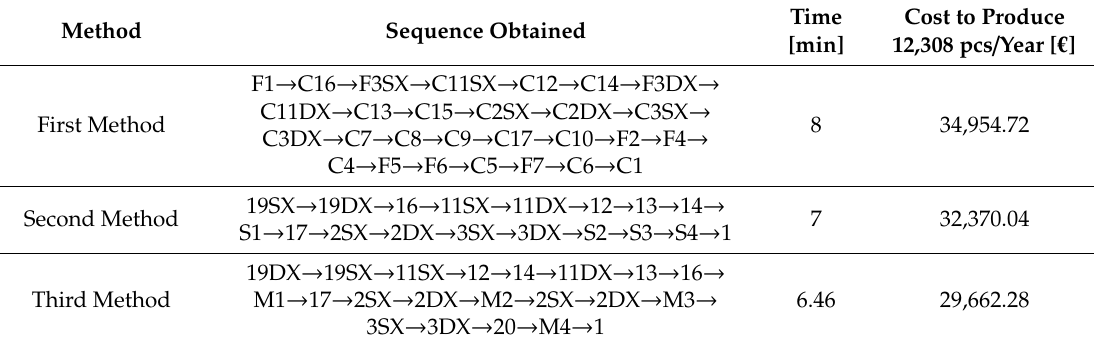
Table 7. Results obtained from the